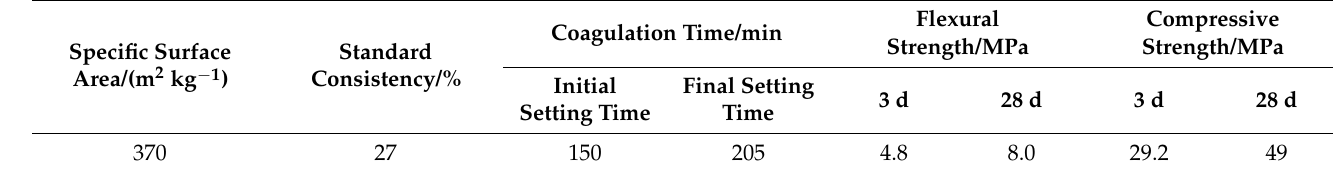
Table 2. Physical and mechanical properties of cement.